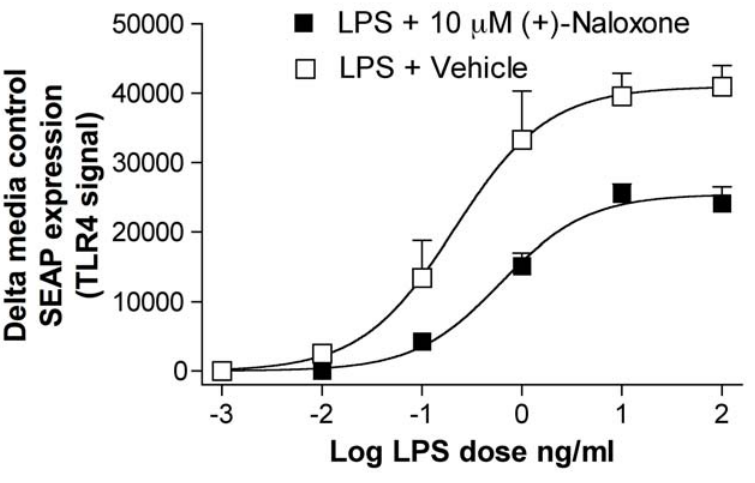
FIGURE 3. (+)-Naloxone noncompetitively antagonizes activation of TLR4 by LPS. A TLR4 (cloned human receptor) stably transfected cell line was incubated for 24 h with LPS, with or without 10 μ M (+)-naloxone. SEAP expression was quantified as an indirect measure of TLR4 activation. LPS alone produced an EC 50 of 0.21 ng/ml with an E max of 40,956 (arbitrary fluorescence units, change from media and (+)-naloxone alone controls). (+)-Naloxone (10 μ M ) produced a significant threefold increase in the EC50 and a 40% reduction in the E max , while having no effect on basal unstimulated SEAP expression and, therefore, no effect on basal NF- κ B